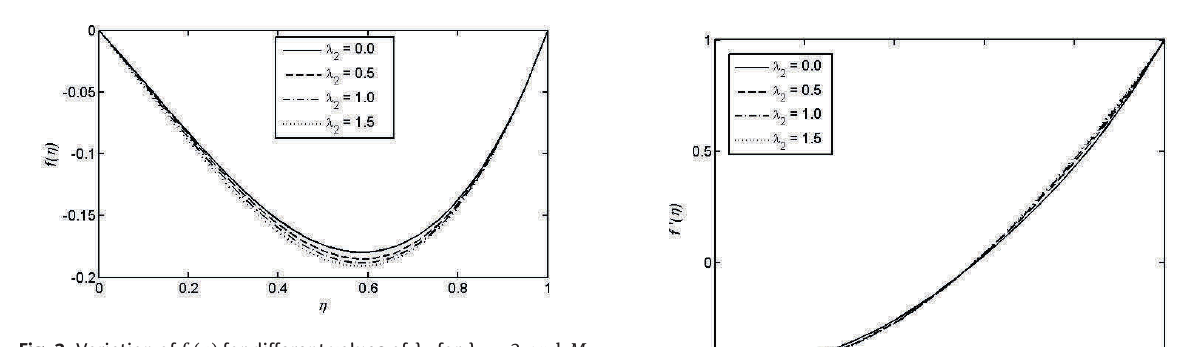
Fig. 3: Variation of f ( η ) for different values of λ 2 for λ 1 = 2 and M = 0.5.